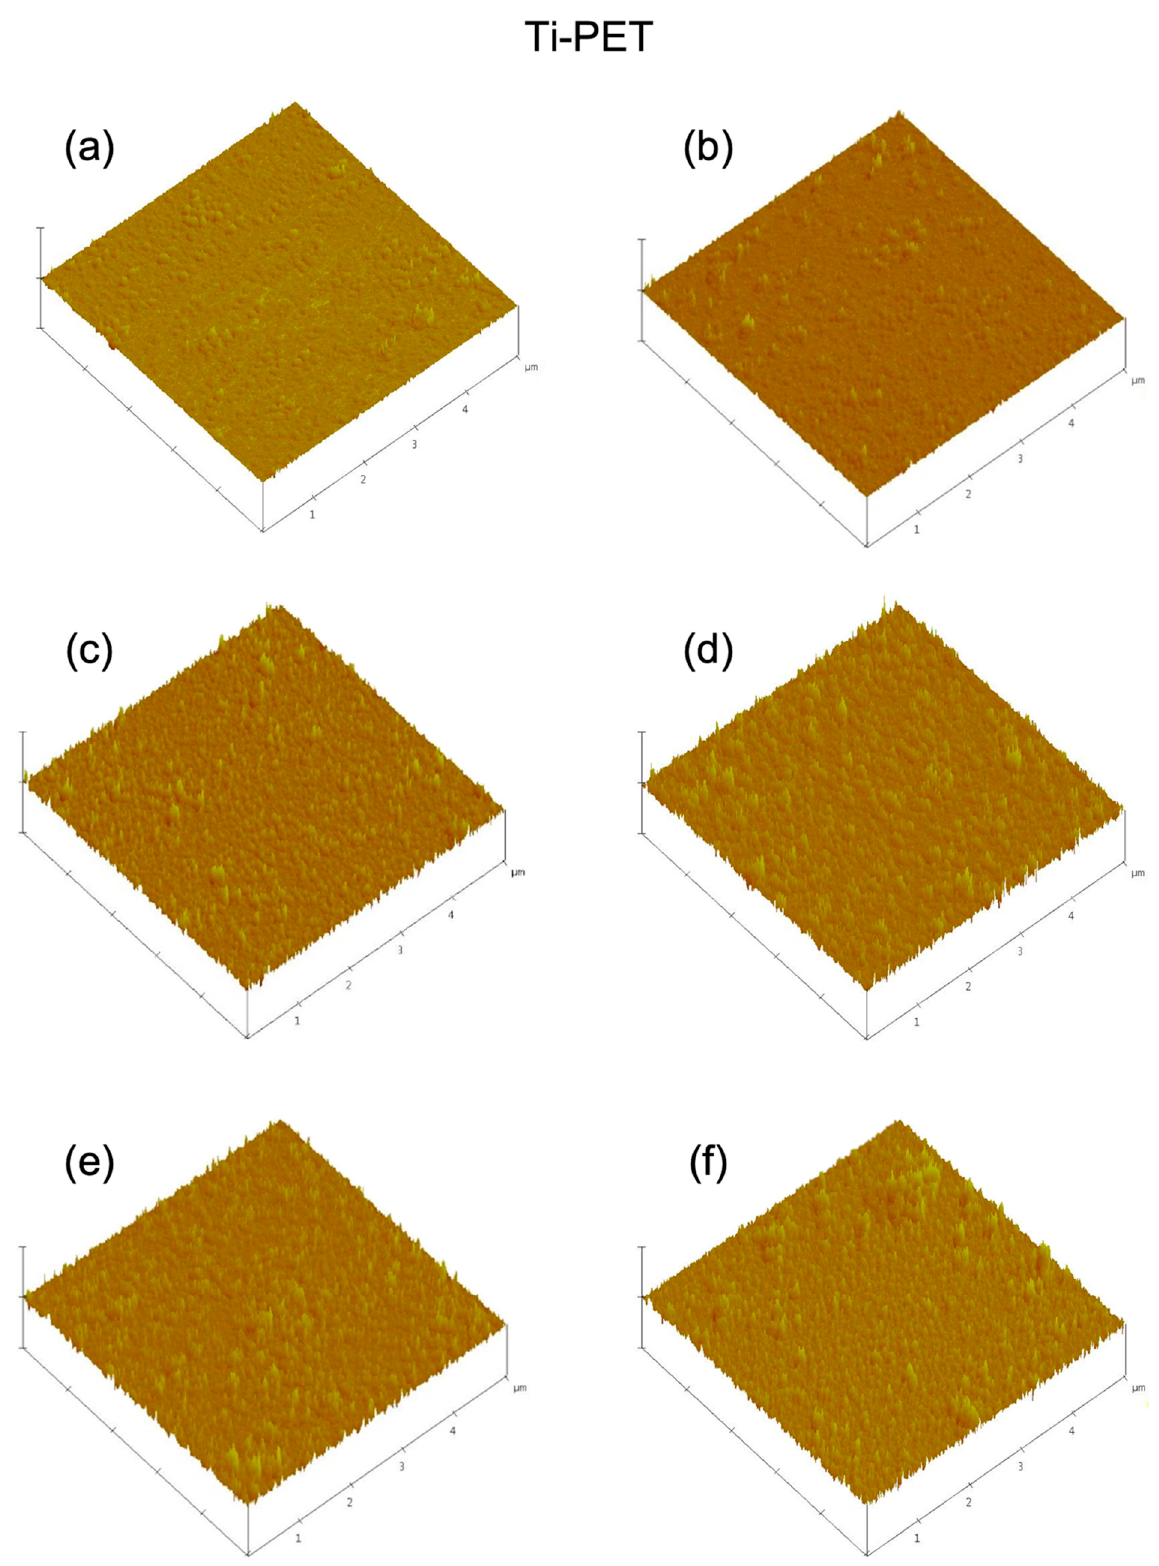
Figure 4. Atomic force microscopy (AFM) images of the Ag-PET, Zn-PET, and Ti-PET films treated